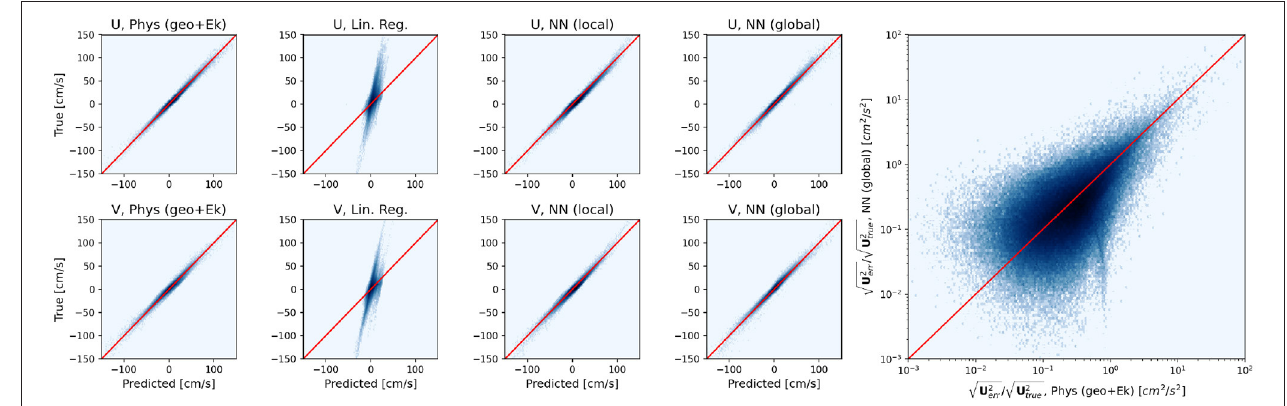
FIGURE 7 | Scatterplot of true v predicted zonal and meridional velocities for the different physical and regression models (eight panels on the left) in the ACC region. The right panel shows the scatterplot of the root mean squared errors (normalized by the root mean square velocities) for the physical and neural network model predictions.